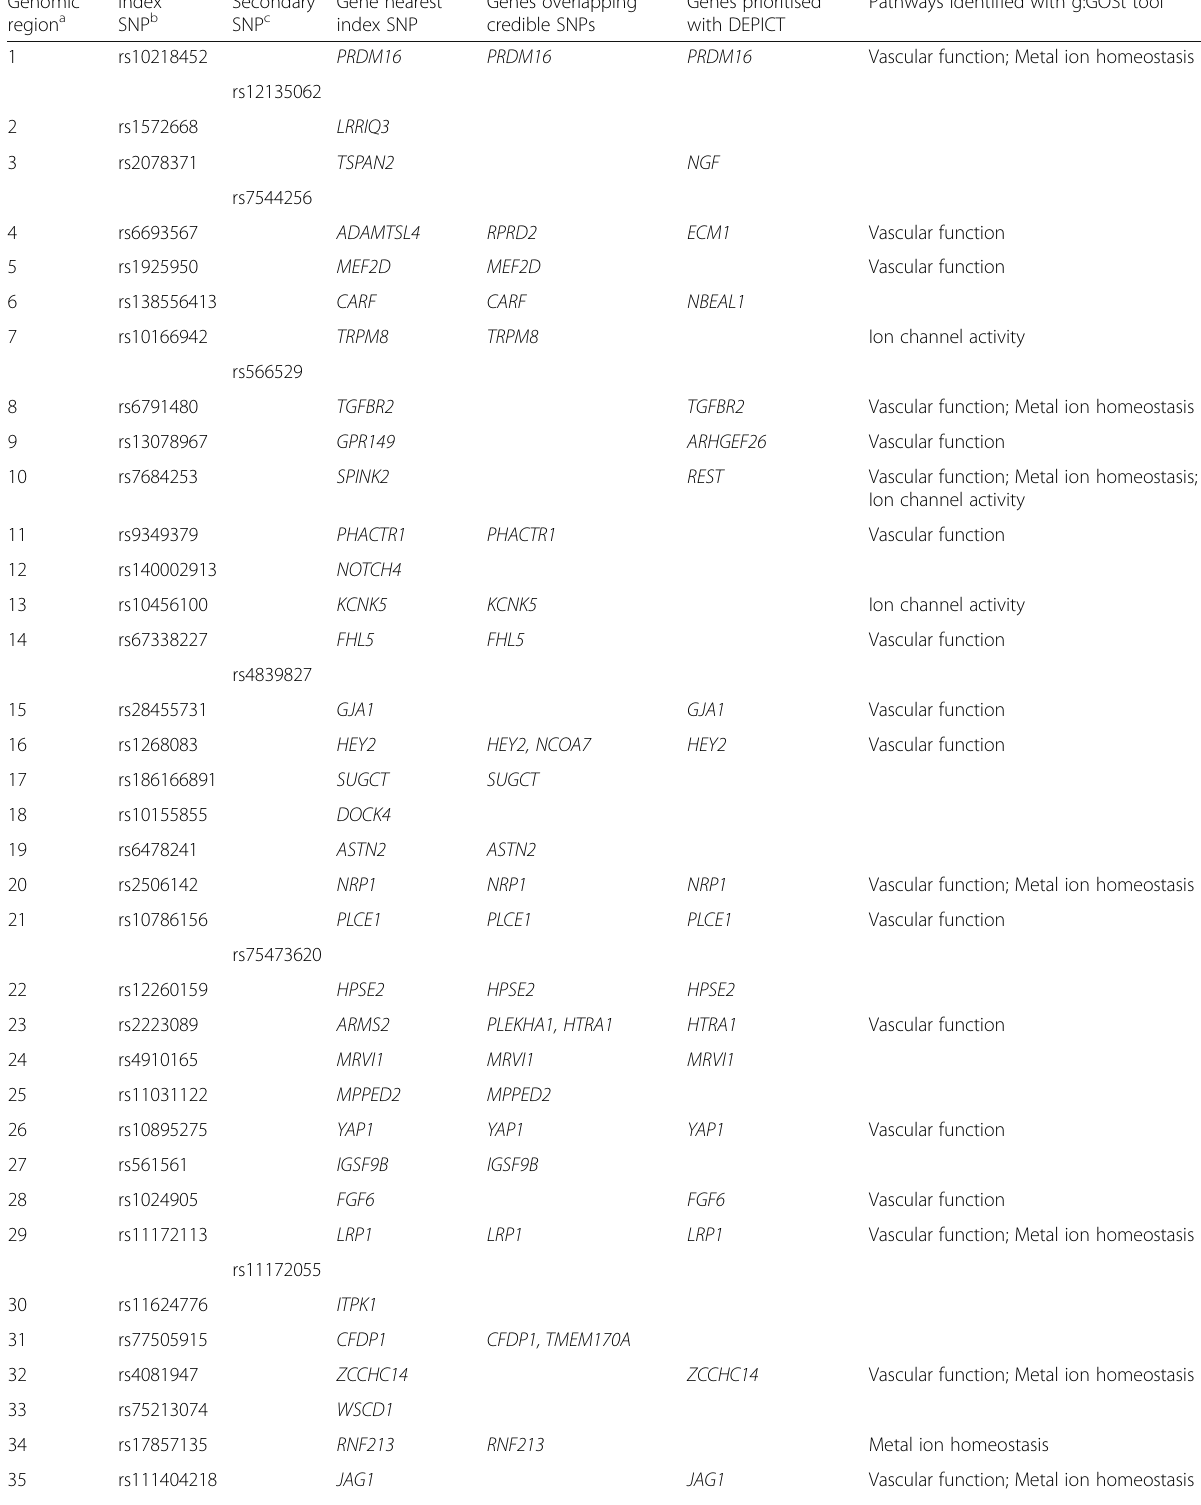
Pathways identified with g:GOSt